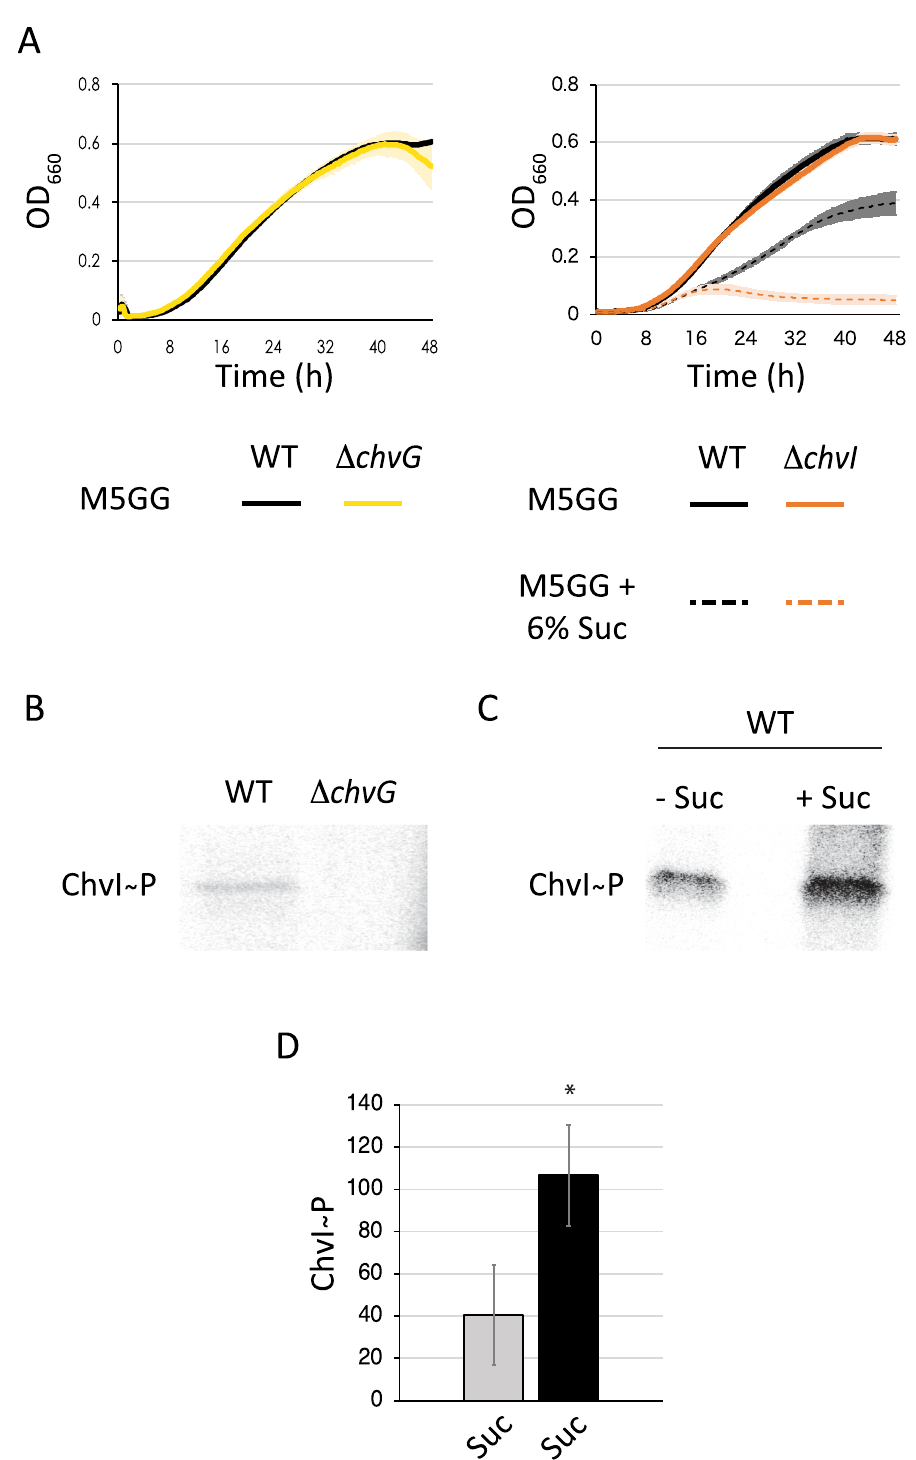
Fig 4. ChvG-dependent phosphorylation of ChvI is stimulated upon osmotic shock. (A) Growth of WT (black) and Δ chvG (yellow) in M5GG, WT and Δ chvI (orange) mutants in M5GG with (dashed lines) or without (solid lines) 6% sucrose (Suc). The data represent the average value of biological replicates (n = 3, error bars show standard deviation). (B) In vivo phosphorylation levels of ChvI in WT and Δ chvG mutant grown in M5GG. (C) in vivo phosphorylation levels of ChvI in WT grown in M5GG exposed (+) or not (-) to sucrose (Suc) for 7 min. (D) Quantified in